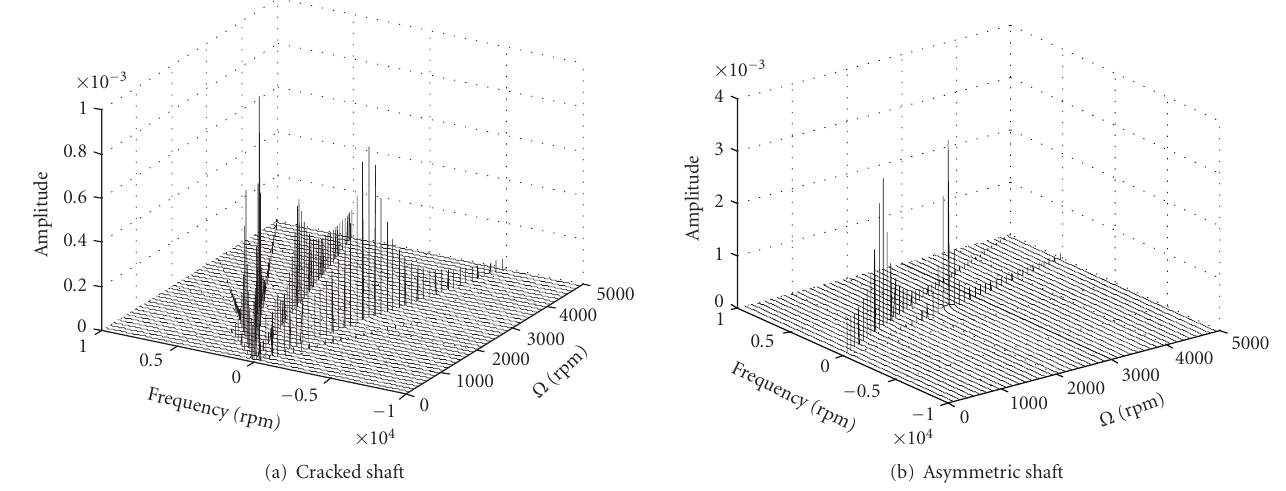
Figure 9: Full spectrum lateral vibration: ω t /ω n = 1.38; ω n = 2400 rpm, Table 3 parameters.